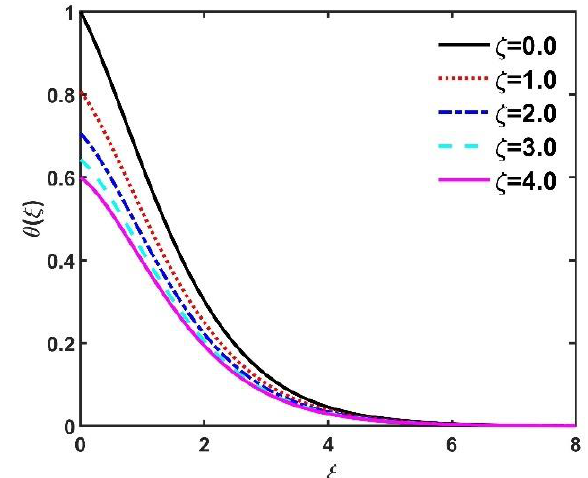
Figure 19. Impact of 𝜁 on 𝜃(𝜉) .